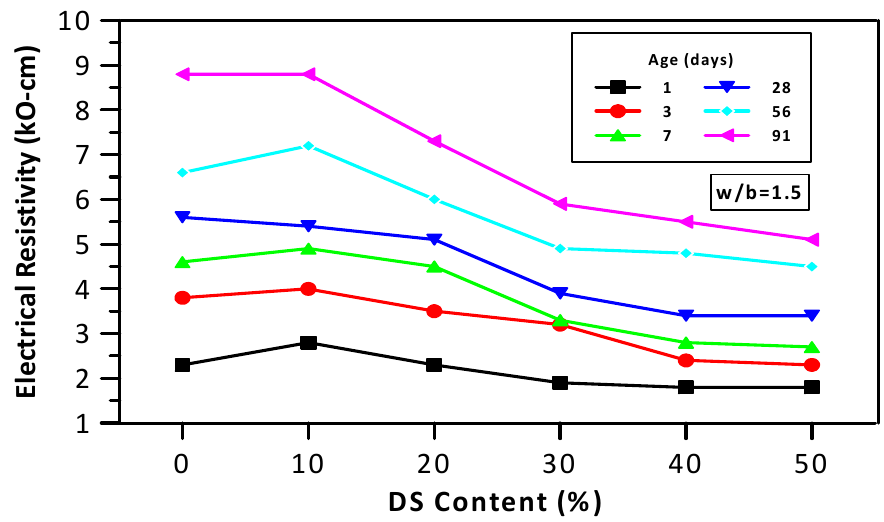
Figure 5. The relationship between the DS content and surface resistivity of the CLSM.